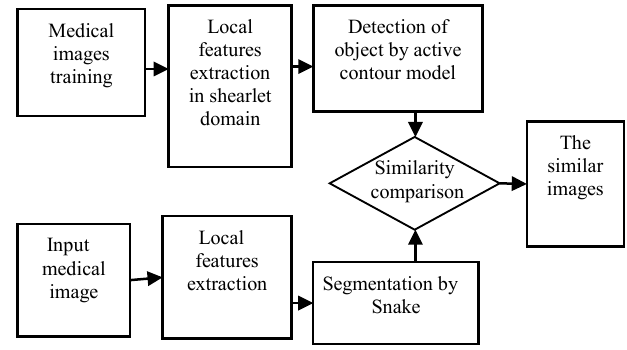
Figure 1 . The proposed method for medical image retrieval